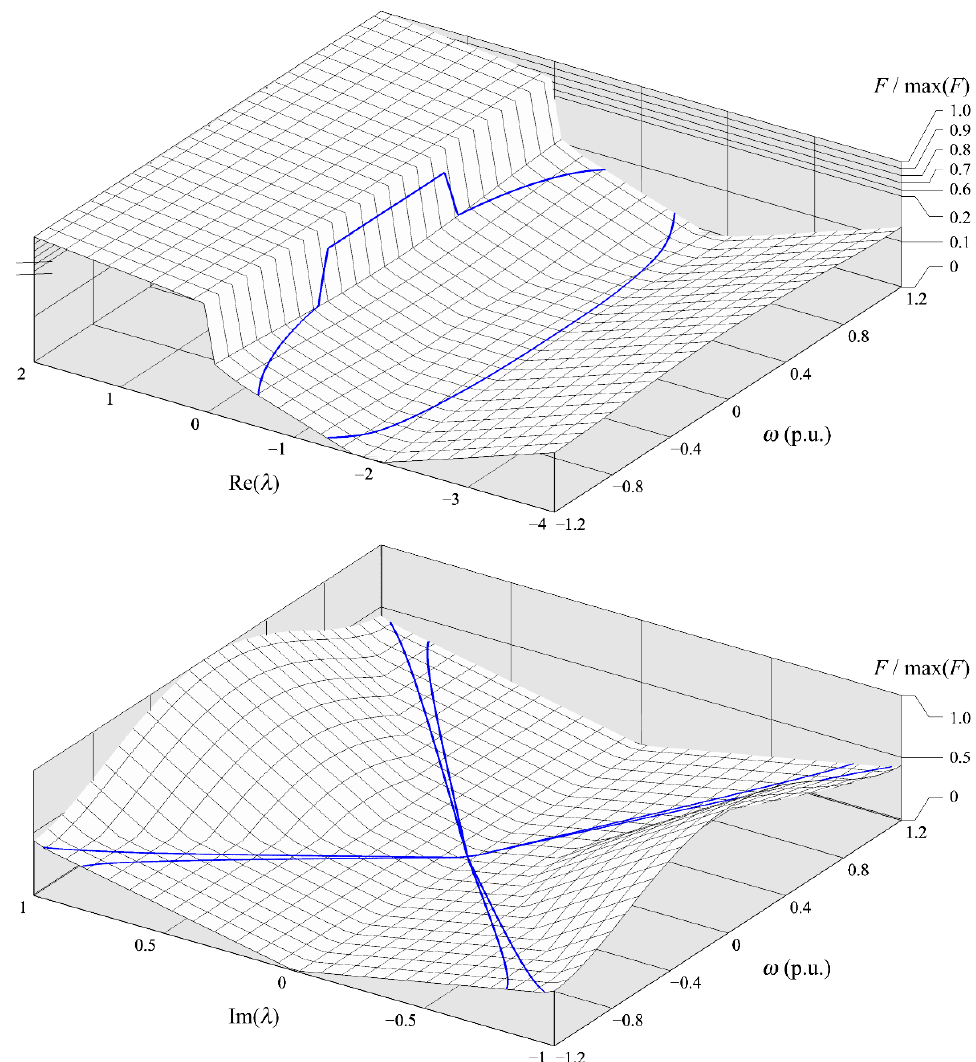
Figure 4. The value of the fitness function versus eigenvalues of the observer and the angular speed of the motor.